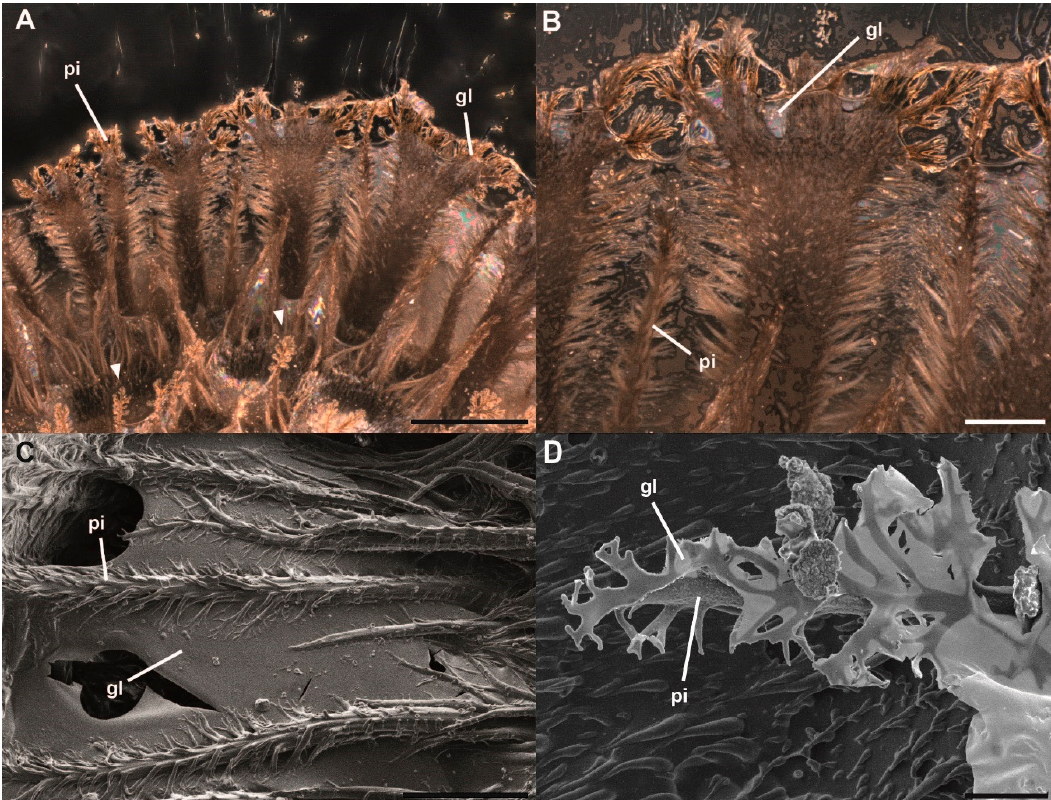
Figure 4. Glue associated with Phyllium philippinicum pinnae . ( A,B ) Stereomicroscopic images of pinnae attached to a glass surface, view through the glass slide. ( A ) Glue deposition on a glass surface and pinnae interaction with the substrate (arrowheads). ( B ). Reinforcement and distribution of the